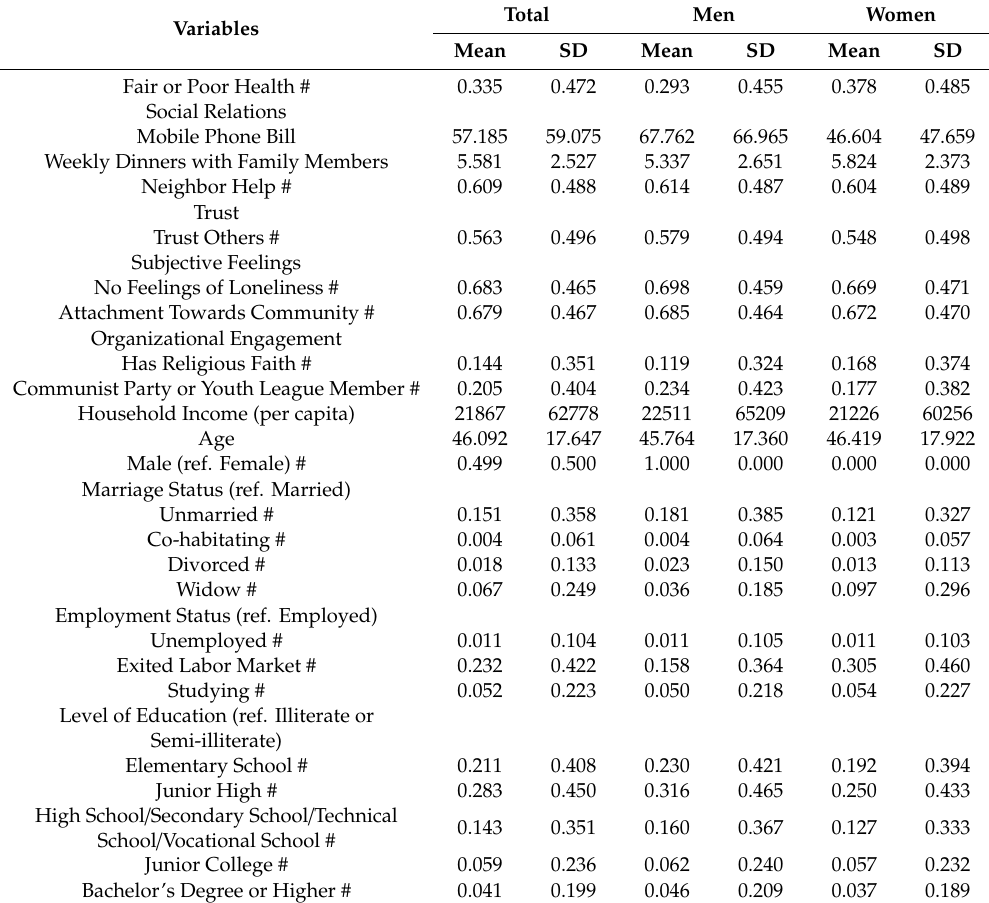
Table 1. Descriptive